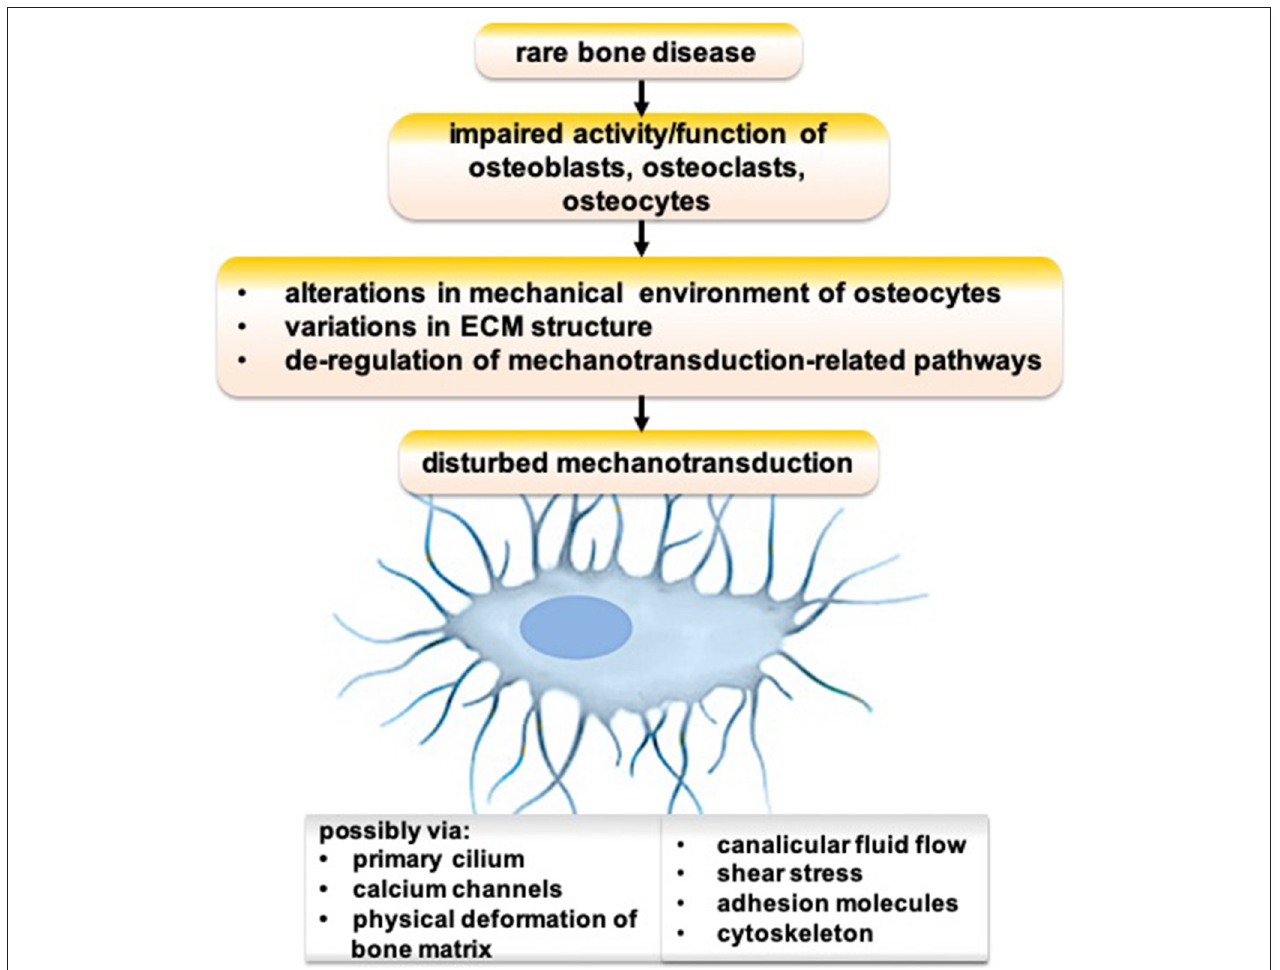
FIGURE 1 | Schematic showing the possible mechanism of disrupted osteocyte functions in rare bone